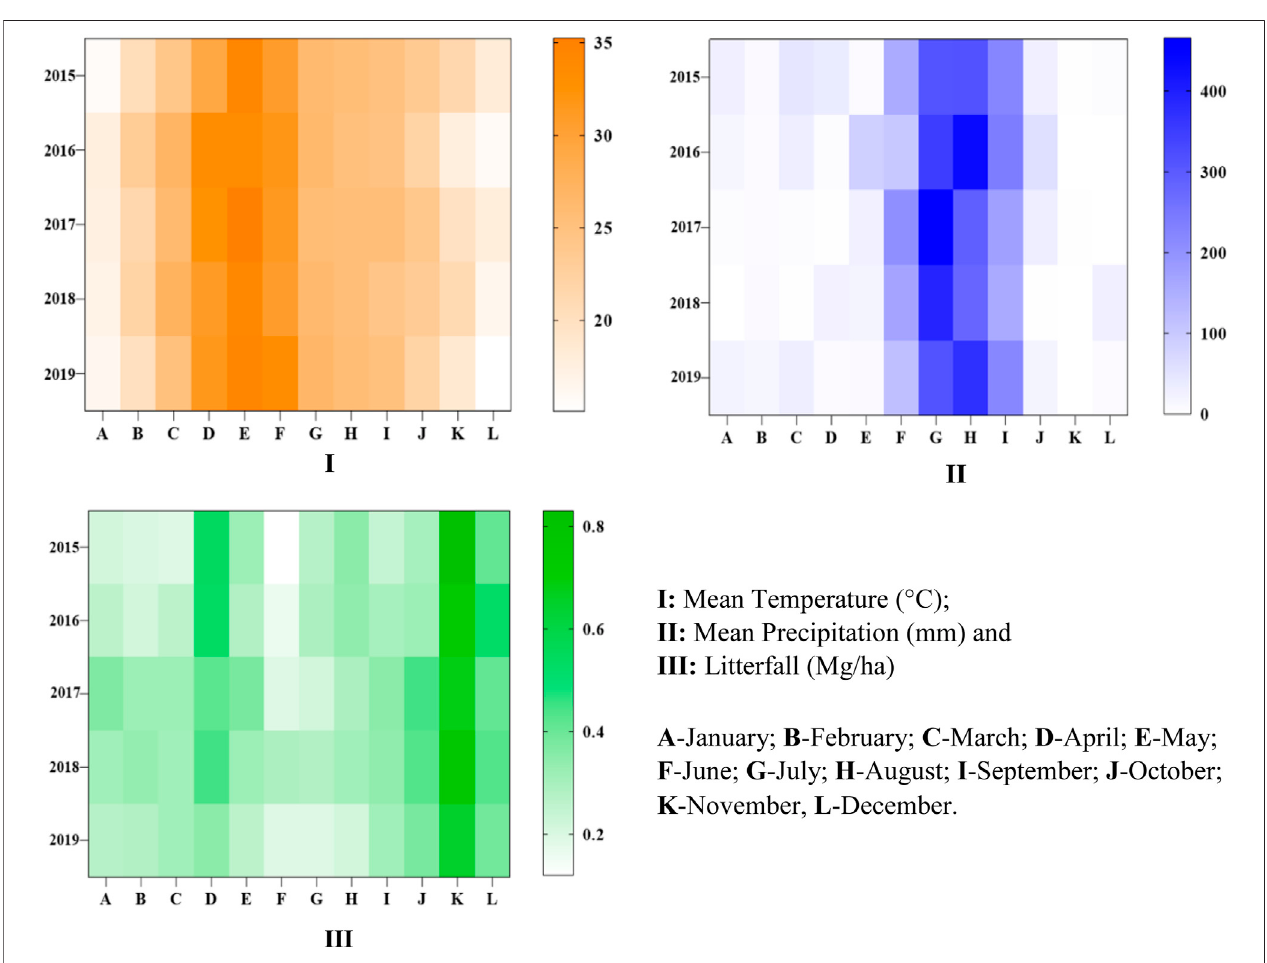
FIGURE 2 | Monthly estimation of various parameters recorded in AABR for the period 2015 – 2019. (I) : mean temperature ( ° C); (II) : mean precipitation (mm), and (III) : litterfall (Mg/ha). A -January; B -February; C -March; D -April; E -May; F -June; G -July; H -August; I -September; J -October; K -November, L -December.